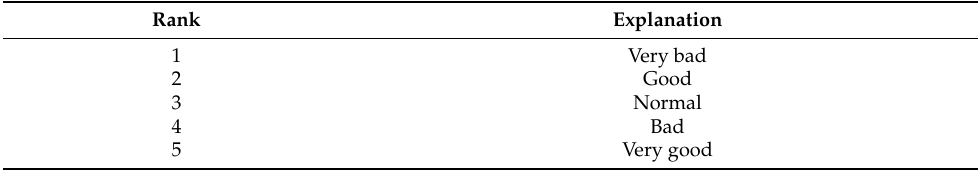
Table 2. Evaluation rank used for ranking BPM tools.